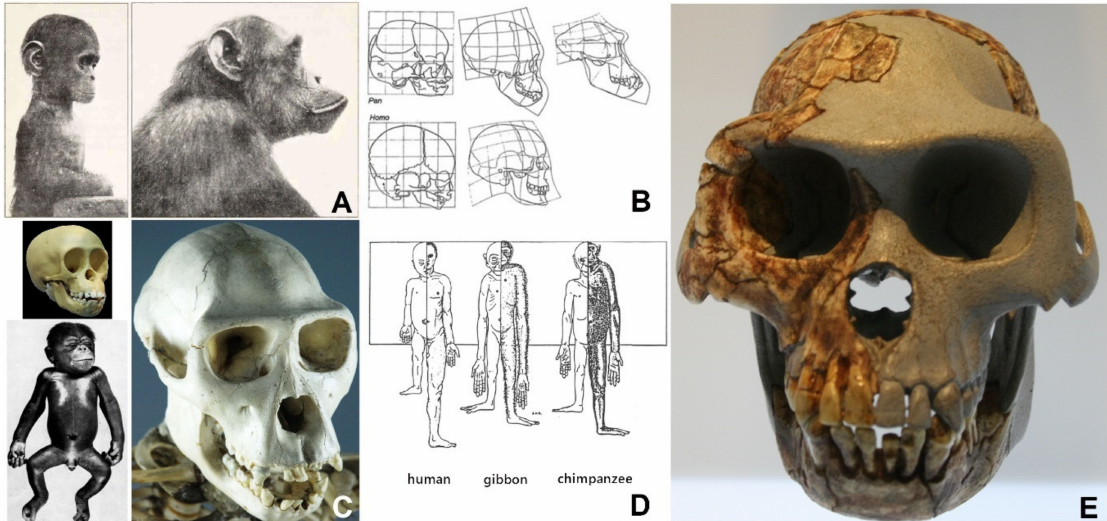
Figure 6. The development of the idea of neoteny in human. ( A ). Photograph of a chimpanzee child and an adult chimpanzee from Naef (1926) [60]. ( B ). The top row shows the growth and shape of the skull in a fetus, cub, and adult chimpanzee, and the bottom row shows the skull of a fetus and an adult human. The direction of transformation is the same: negative skull allometry is seen as the skull grow slower than the rest of the body and is therefore being proportionally smaller in adults than in children (hypoallometry) and positive allometry of the face and jaw growing faster than the rest of the body and therefore proportionally higher in adults than in children (hyperallometry); image from Starck and Kummer (1962) [61]. ( C ). Skulls of young and adult chimpanzees (from commons.wikimedia.org) for comparison with Figures A and B. In the lower left corner is a picture of a seven-month-old chimpanzee fetus. Hair growth can be seen on the head, in the eyebrow area, the edges of the eyelids, lips, and cheeks, i.e., in those places where we see them today in adults, which is considered as another proof of neoteny in human; image from the University of Wisconsin Public Digital Repository website (www.omnia.ie). ( D ). Comparative view of infant and adult human, gibbon, and chimpanzee, all aligned with height in sitting position (frame represents trunk and head size). Lesser apes (gibbons) have extremely long front limbs, even at birth. The legs always grow faster than the trunk, especially in a human. The newborn has relatively short arms at birth. Note smaller hands and feet in man. The image transferred from Verhulst (1993) [62], originally drawn by Schultz (1926) [63]. ( E ). Cast of a reconstructed skull of the Ardipithecus ramidus . Note the flattened face and pronounced orthognathia (the cast is on display at the State Archaeological Museum in Chemnitz, Federal Republic of Germany; image from